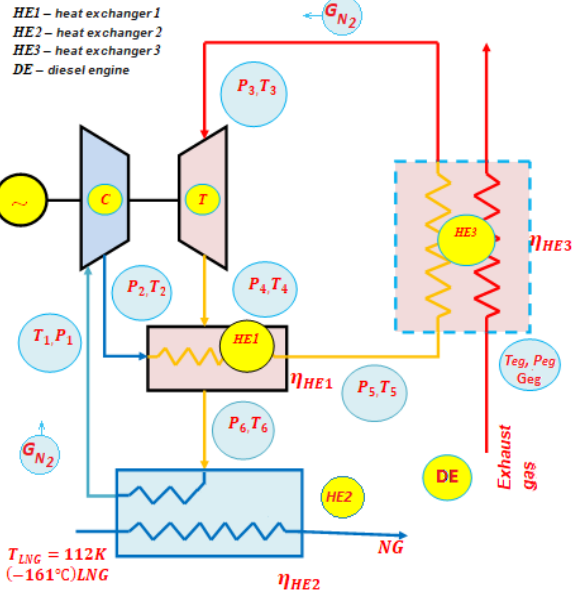
Figure 1. Principal scheme of liquefied natural gas (LNG) ship’s power plant cogeneration cycle (T: turbine; C: compressor; E: engine; HE i : heat exchanger).